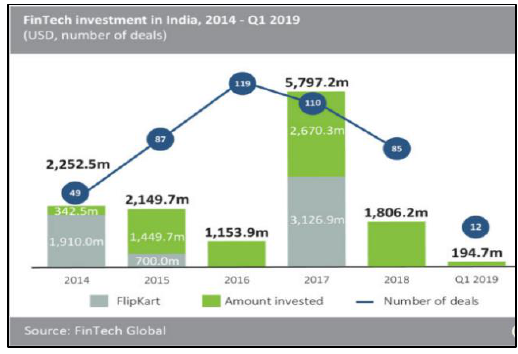
Fig. 5. Investments in World-wide Fintech